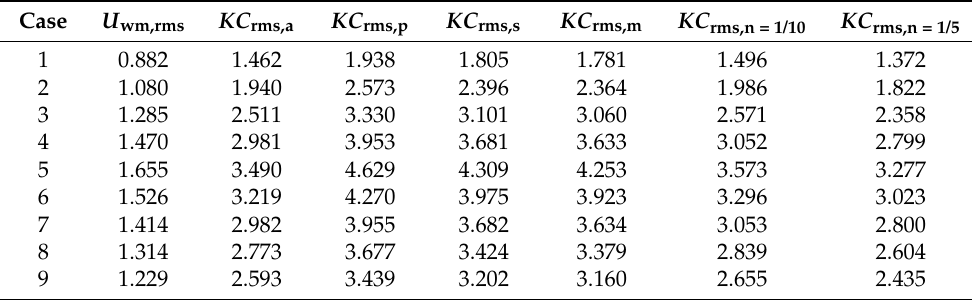
Table 3. U wm,rms and KC for case